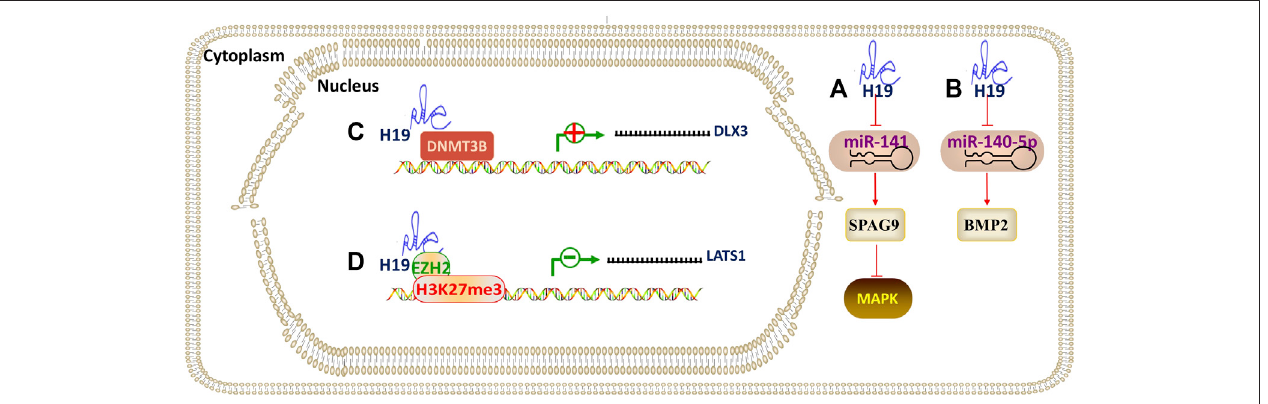
FIGURE 6 | The regulatory mechanism of lncRNA H19. Arrow indicates promotion and T indicates inhibition. (A) H19 promotes osteo/odontogenic differentiation through H19/miR-141/SPAG9/MAPK axis. (B) H19 promotes odontoblastic differentiation through H19/miR-140-5p/BMP-2/FGF9 axis. (C) H19 epigenetically promotesodontoblasticdifferentiationbyinhibitingDNMT3B-mediatedmethylationofDLX3. (D) H19epigeneticallypromotesodontoblasticdifferentiationbyrepressing LATS1 through EZH2-induced trimethylation of H327me3.